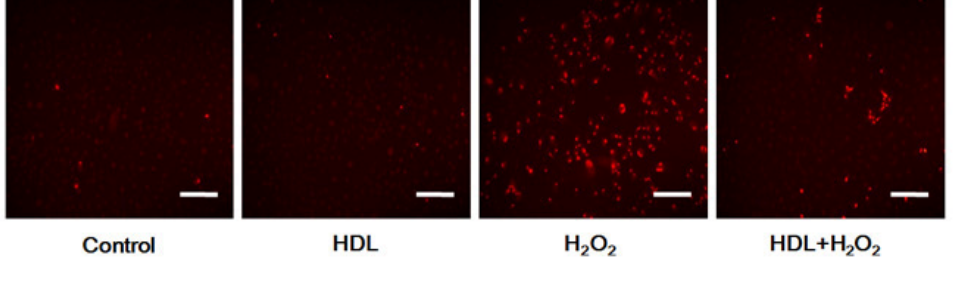
Figure 4. Impact of activation of PI3K/Akt pathway induced by HDL on reactive oxygen species (ROS) generation. The intracellular ROS in MSCs was visualized by fluorescent microscopy. Representative photomicrographs (scale bar = 100 μ m) and corresponding histograms are displayed. Preconditioning with HDL inhibited H pretreatment. Results were confirmed in three independent experiments. * p < 0.05 vs. Control group, # p < 0.05 vs. H ns. , not significant; DMSO, Dimethyl